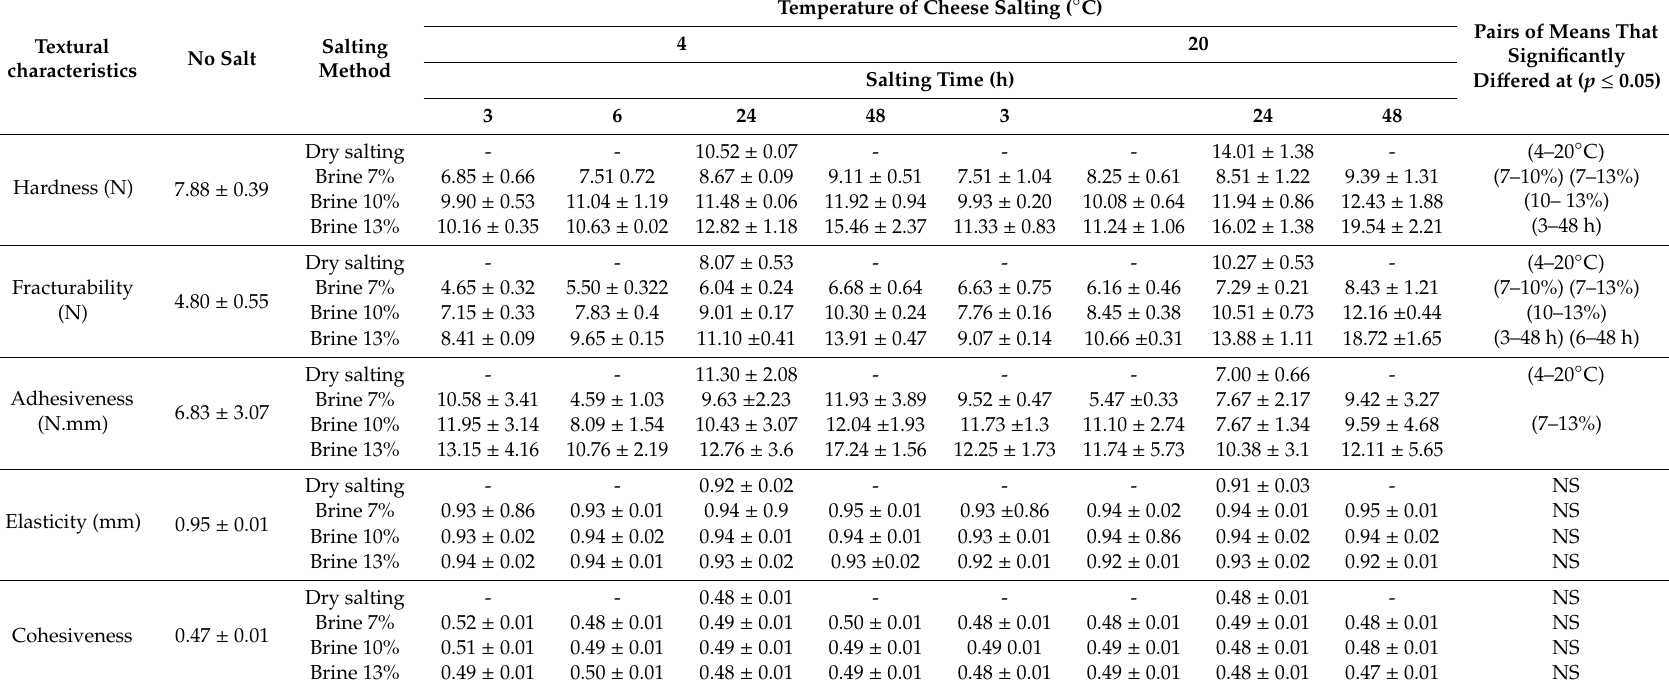
Table 3. Textural characteristics of Halloumi cheese salted by di ff erent methods at 4 and 20 ◦ C for di ff erent times (means of three trials ±